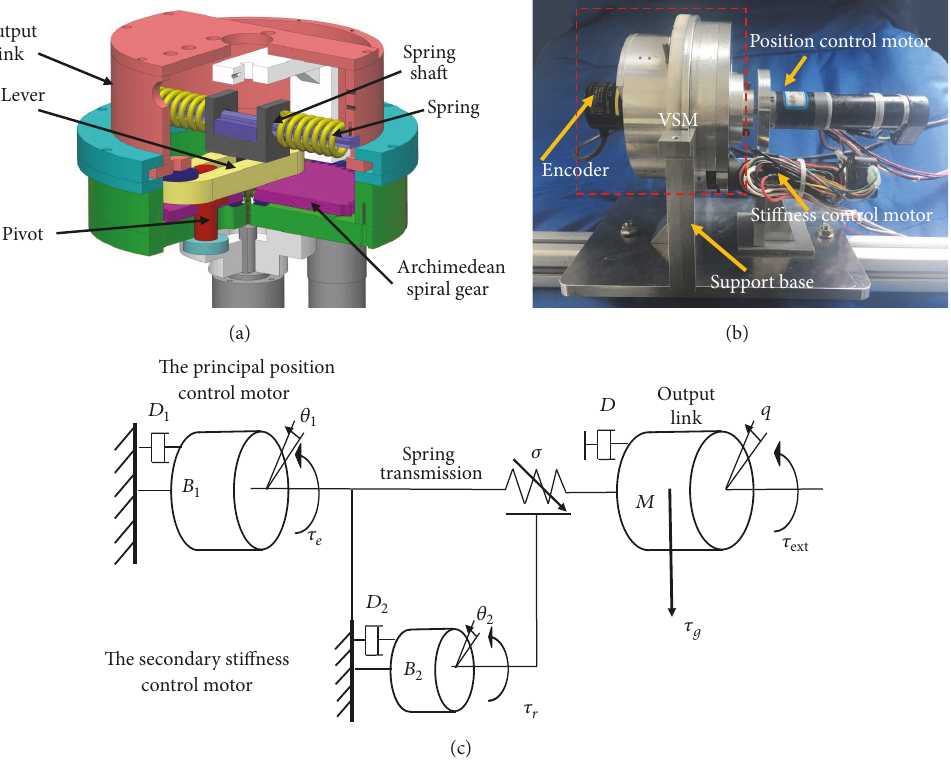
Figure 1: CAD model (a), prototype (b), and schematic model (c) of the